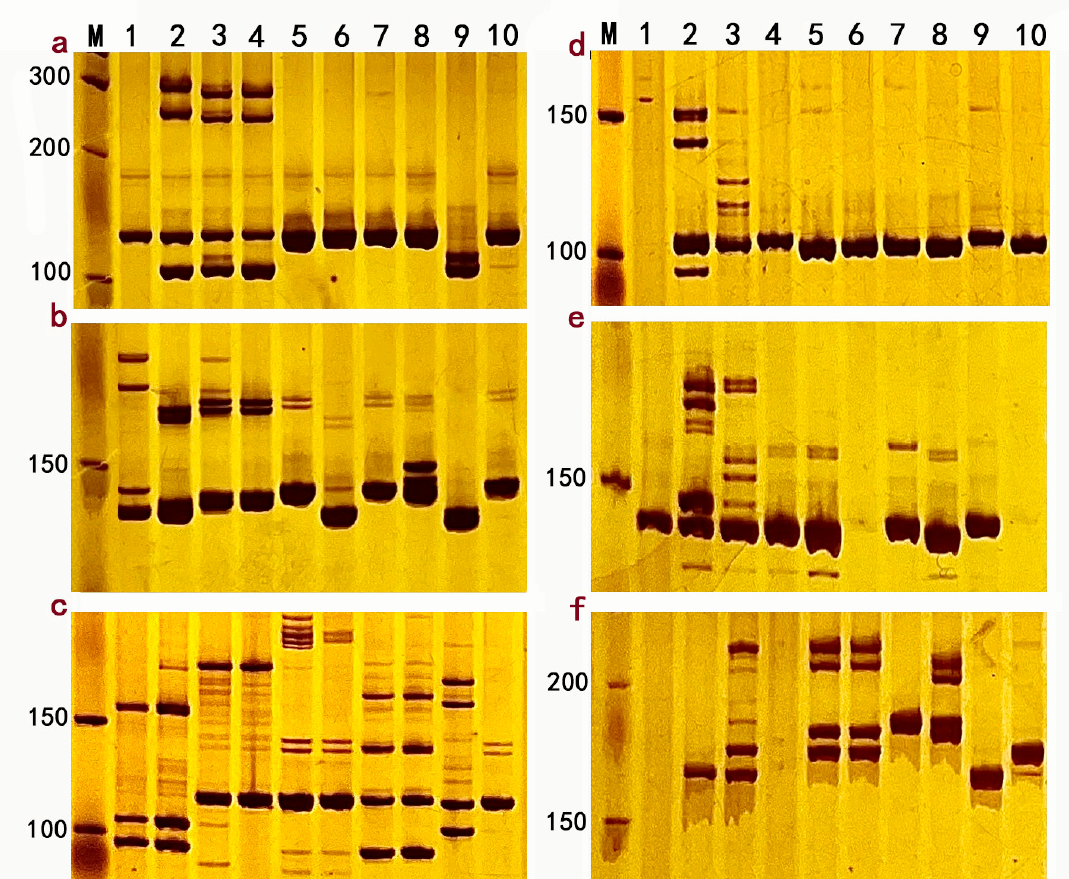
Figure 1. The PCR results of some SSR markers in 10 broccoli genotypes. M, D500 Marker, letters ( a – f ) represent markers LTSSR13, LTSSR81, LTSSR94, LTSSR180, LTSSR340, and LTSSR688, and numbers 1 to 10 represent B368, B578, B606, B611, B831, B910, B936, B1019, B1024, and B1027,